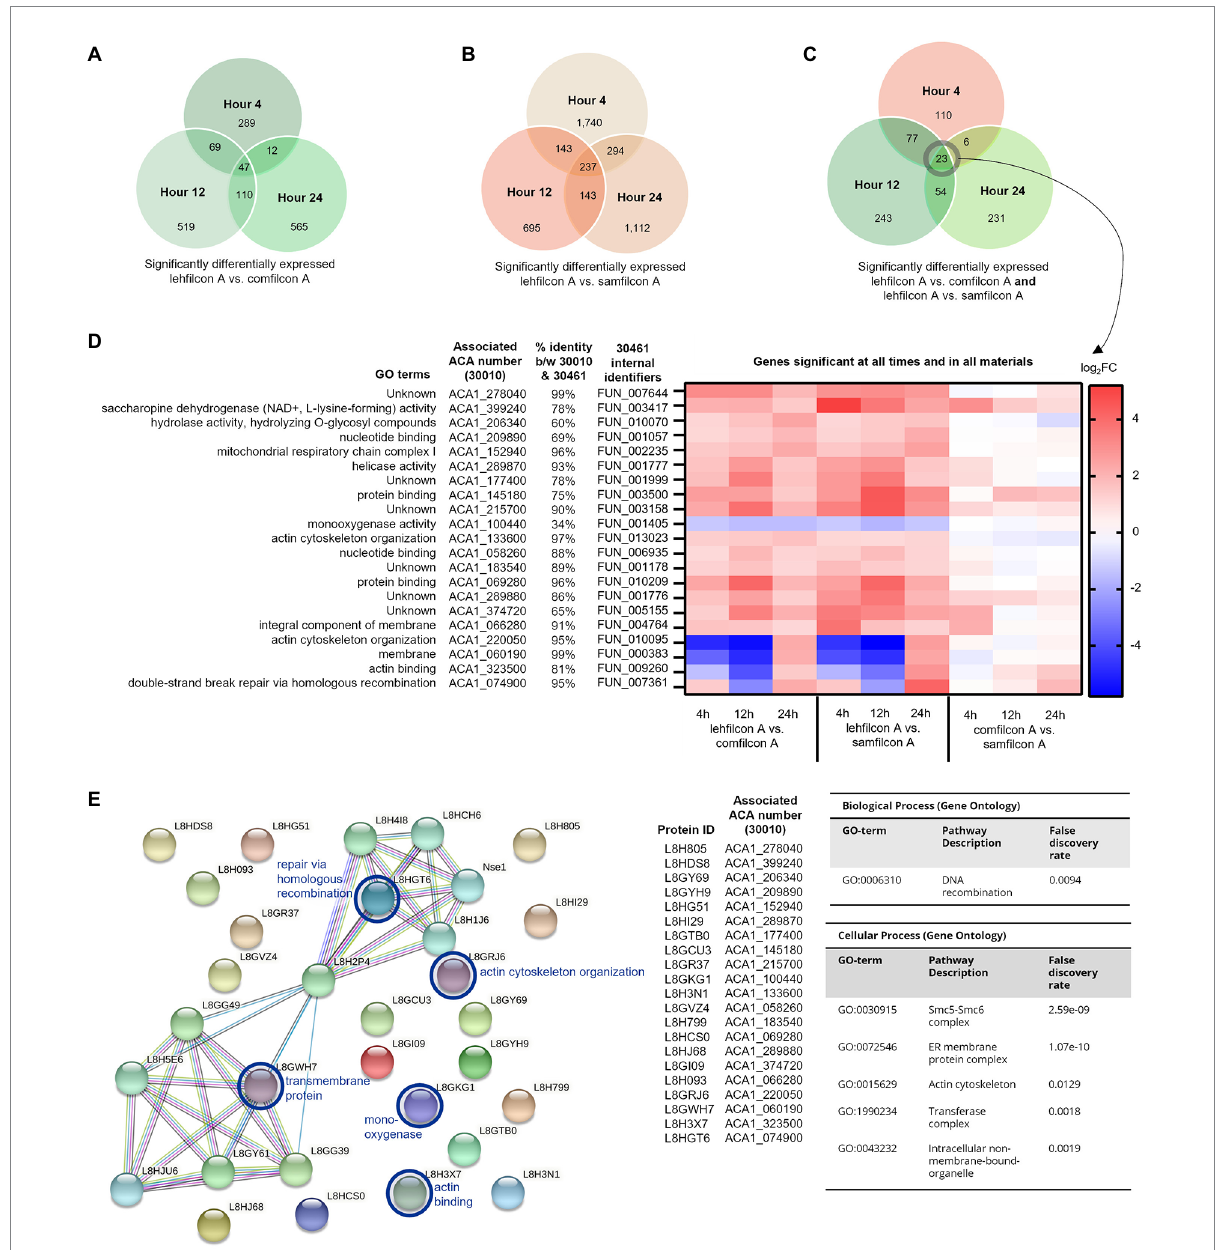
FIGURE 8 Genomic analysis of Acanthamoeba polyphaga (ATCC 30461) on three different contact lens materials at hours 4, 12, and 24. (A) Venn diagram of overlapping genes that were significantly different between lehfilcon A vs. comfilcon A, by hour, (B) Venn diagram of overlapping genes that were significantly different between lehfilcon A vs. samfilcon A, by hour, and (C) Venn diagram of overlapping genes that were significantly different between lehfilcon A vs. comfilcon A and lehfilcon A vs. samfilcon A, by hour. (D) 23 genes were significantly differentially expressed between lehfilcon A and both other materials, and in all three time points; p < 0.05, n = 6 per group. Genes are described according to locus identifier, closest identified homologue in ATCC 30010, and GO terms associated with ATCC 30010 protein according to AmoebaDB. (E) All 21 genes are visualized as proteins and their protein–protein interactions are identified via STRING: significant pathways are identified using a false discovery rate of <0.05. Proteins that were significantly upregulated in aggregating lenses at any timepoint are indicated in the protein–protein interaction map with a blue circle. All other proteins visualized were significantly downregulated in aggregating lenses compared to the non-aggregating lens. Further visualizations of other significant genes presented in Figures 9 and